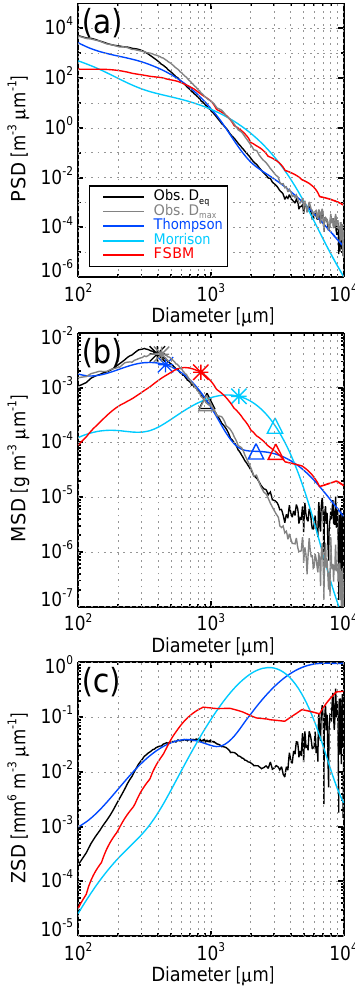
Figure 15. Observed and simulated composite average (a) PSDs, (b) MSDs, and (c) ZSDs for TWC between 2 and 2.5gm − 3 and temperatures between − 32 and − 40 ◦ C, where TWC is the inte- grated mass in diameters less than the observational maximum of 12.85mm. Observed distributions for the D eq diameter definition are in black, and those for the D max definition are in grey. Thomp- son is in dark blue, Morrison in cyan, and FSBM in red. Asterisks and triangles overplotted on the MSDs in (b) are the MMD and 90% MD, respectively. Note that both axes are